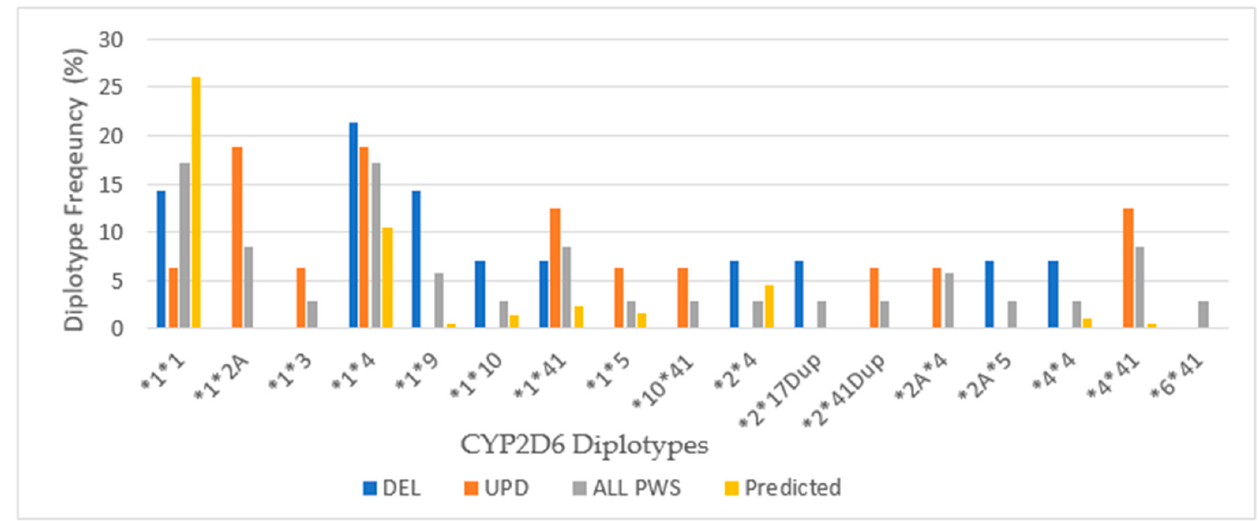
Figure 6. Cytochrome 2D6 diplotype frequencies among PWS DEL ( n = 14), UPD ( n = 16) and combined cohort (ALL PWS, n = 35) compared to predicted, American normative data [http:// www.pharmgkb.org/page/cyp2d6RefMaterials ].